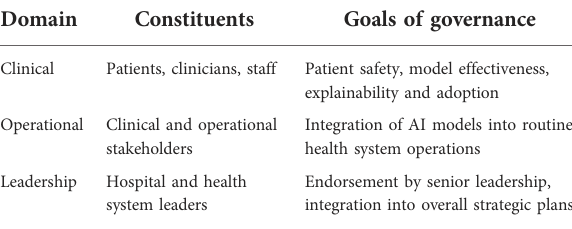
TABLE 1 Challenges to the adoption of AI categorized by domains with associated constituencies and